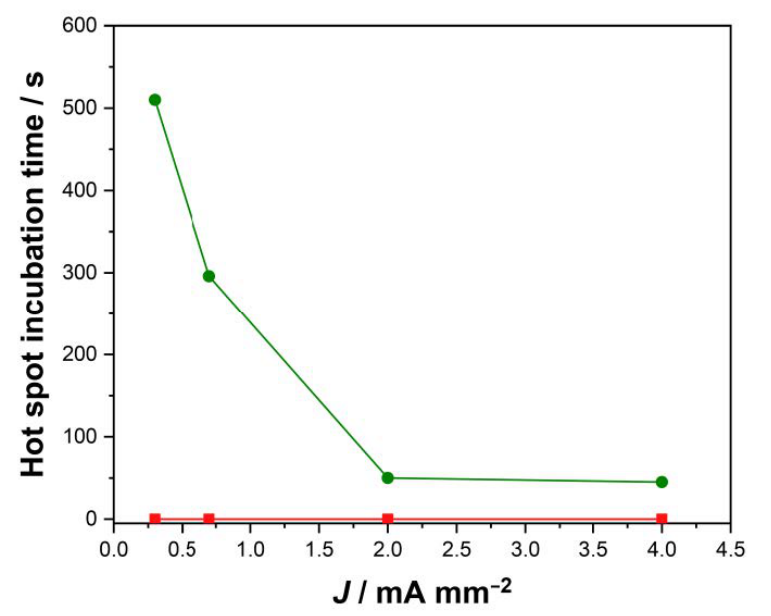
Figure 10. Hot spot incubation time for the platinum (red)- and silver (green)-plated samples, as a function of the applied current